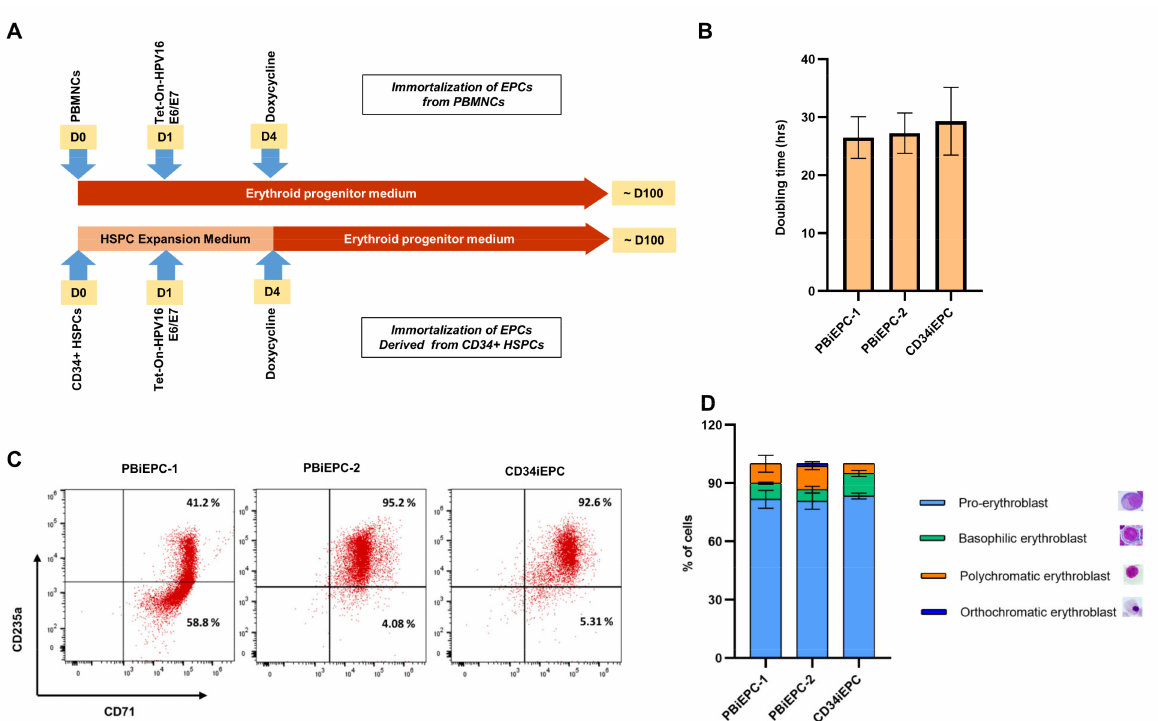
Figure 2. Generation of iEPCs from PBMNCs and CD34 + HSPCs. ( A ) Illustration of the steps involved in the generation of iEPCs from PBMNCs (top) and CD34 + HSPCs (bottom). ( B ) Graph showing the doubling times of PBiEPC-1 and PBiEPC-2 generated from PBMNCs and CD34iEPC generated from CD34 + HSPCs. ( C ) Flow cytometry analysis of the expression of erythroid surface markers, CD71 and CD235a, in the undifferentiated iEPCs. ( D ) Percentages of different types of EPCs present in the undifferentiated iEPCs (data from three different passages are